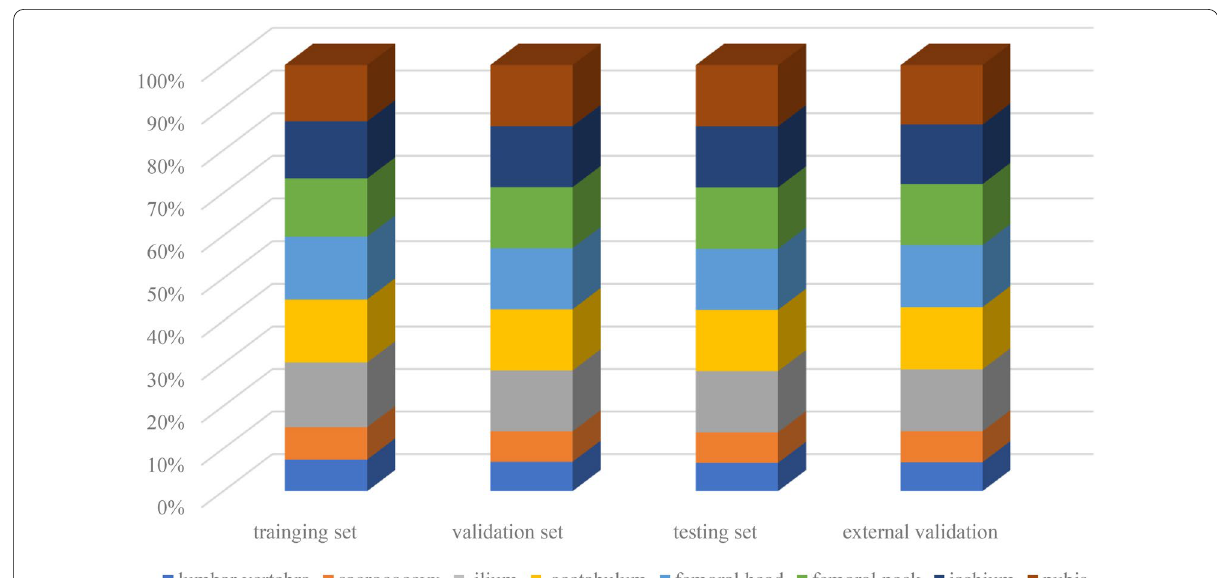
Fig. 4 The distribution of different connected domains. The distribution of the connected domains among four data sets shows that all bones had roughly equal distribution in different data sets